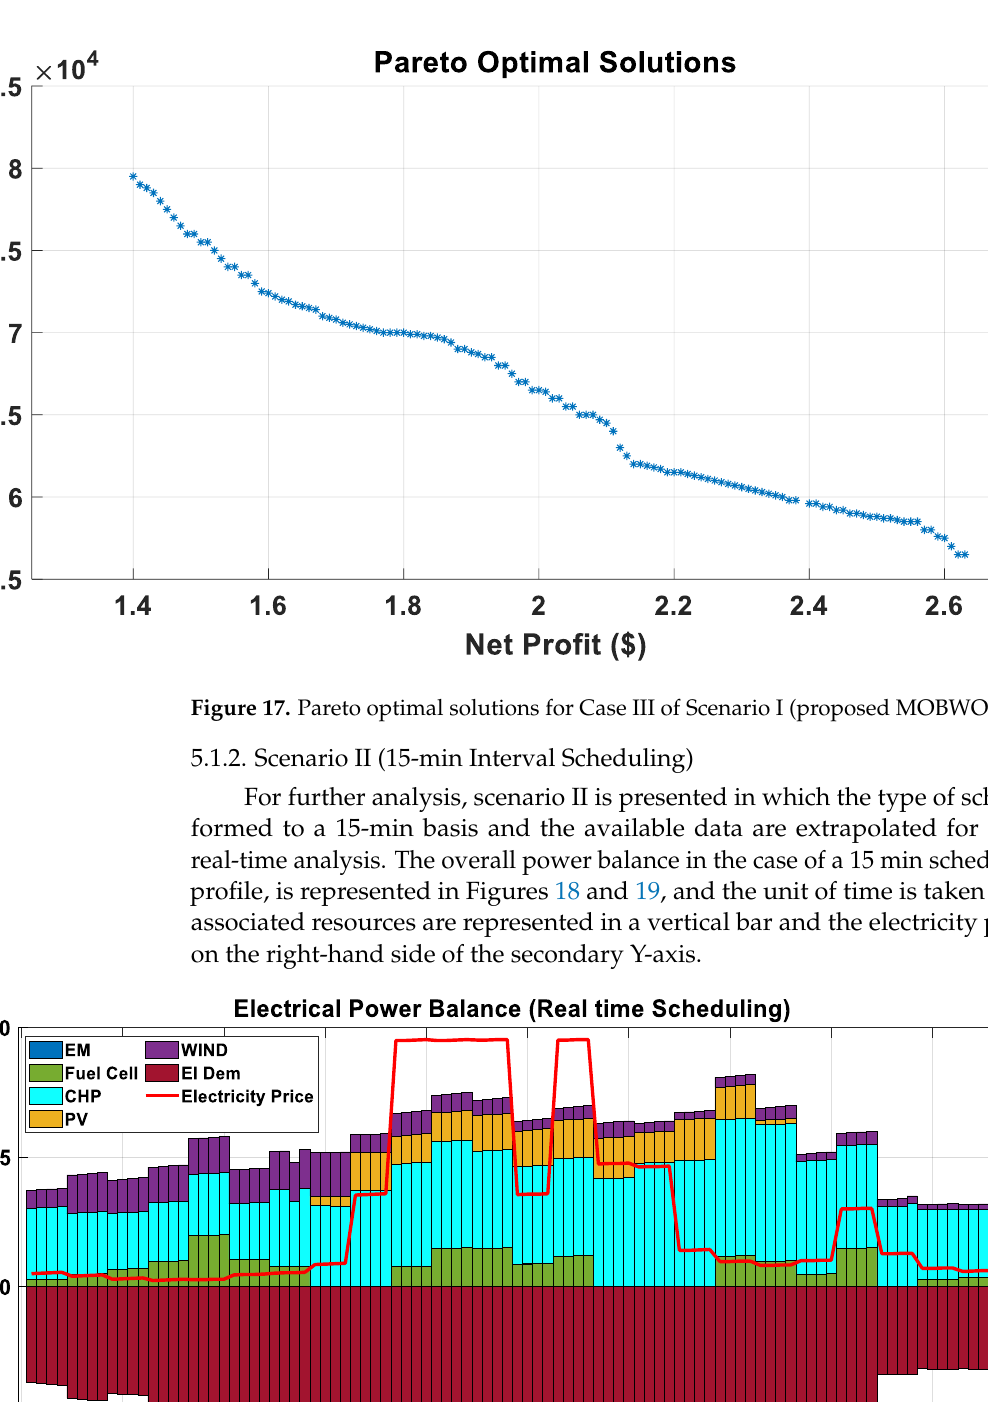
23 of 30 Table 9. Comparison of emissions with different techniques. Period